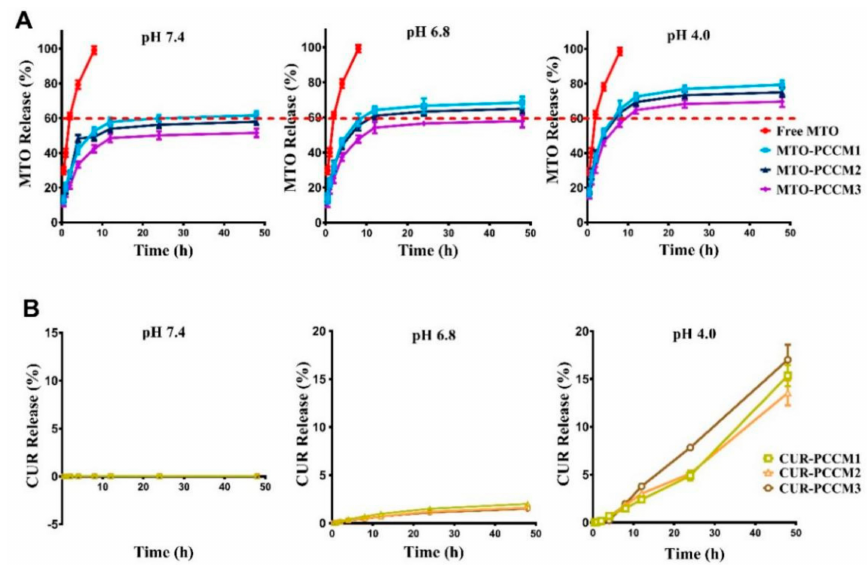
Figure 6. In vitro release profiles of Mitoxantrone (MTO) ( A ) and CUR (CUR) ( B ) from PCCM NPs in pH 7.4, 6.8 and 4.0 conditional